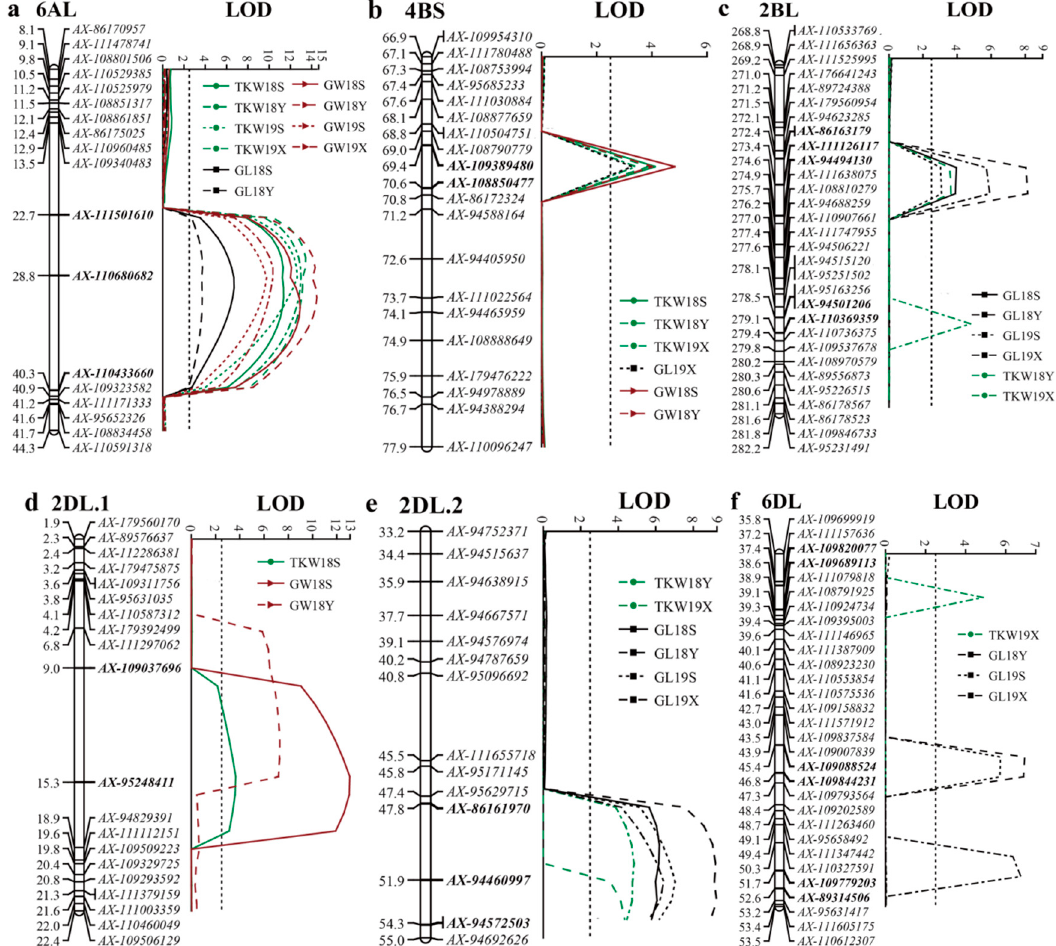
Figure 2. Linkage map and LOD profile of co-located QTLs for thousand kernel weight (TKW), grain length (GL) and grain width (GW) on chromosome 6AL ( a ), 4BS ( b ), 2BL ( c ), 2DL.1 ( d ), 2DL.2 ( e ) and 6DL ( f ), respectively, in the ‘HN5290’ × ‘06Dn23’ recombinant inbred lines (RILs) population; the flanking markers for each QTL are in bold.